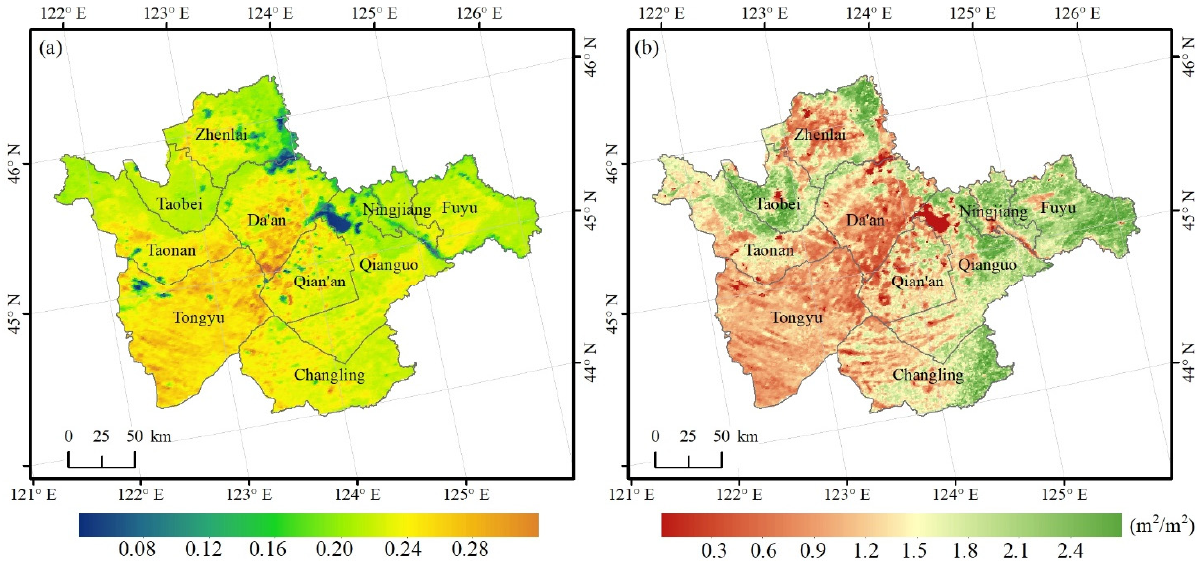
Remote Sens. 2021 , 13 , 3407